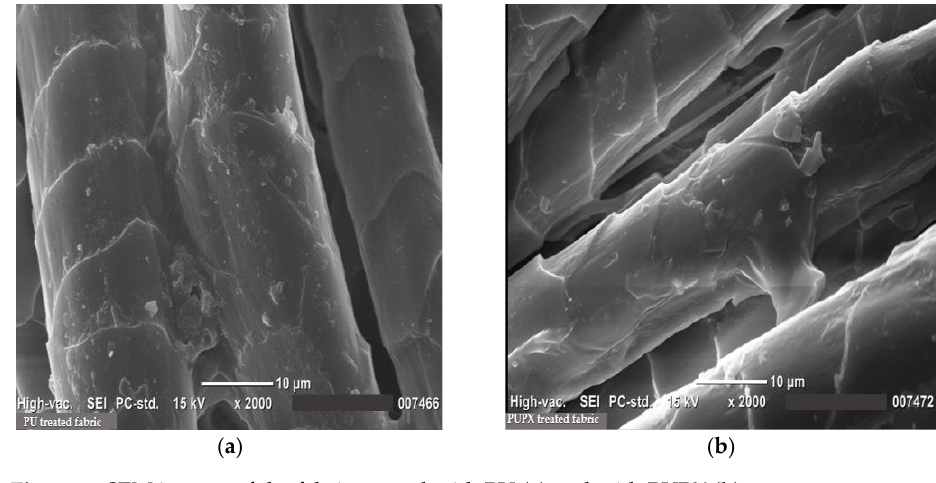
Figure 6. SEM images of the fabric treated with PU ( a ) and with PUPX ( b